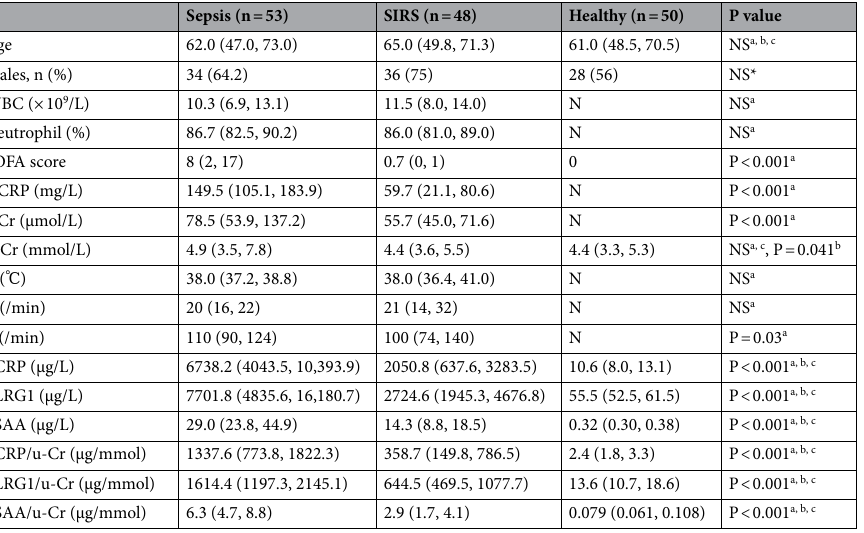
Table 3. Subject characteristics and quantitative analysis. Variables are expressed as median (25% percentiles, 75% percentiles); Mann–Whitney U test or chi-square test were performed to test the statistical significance between different groups; a, tested by Mann–Whitney U test between the sepsis group and SIRS group; b, tested by Mann–Whitney U test between the sepsis group and healthy control group; c, tested by Mann– Whitney U test between SIRS group and healthy control group; *, tested by chi-square test; Significance level is P < 0.05. WBC white blood cell, s-CRP serum C-reactive protein, s-Cr serum creatinine, u-Cr urinary